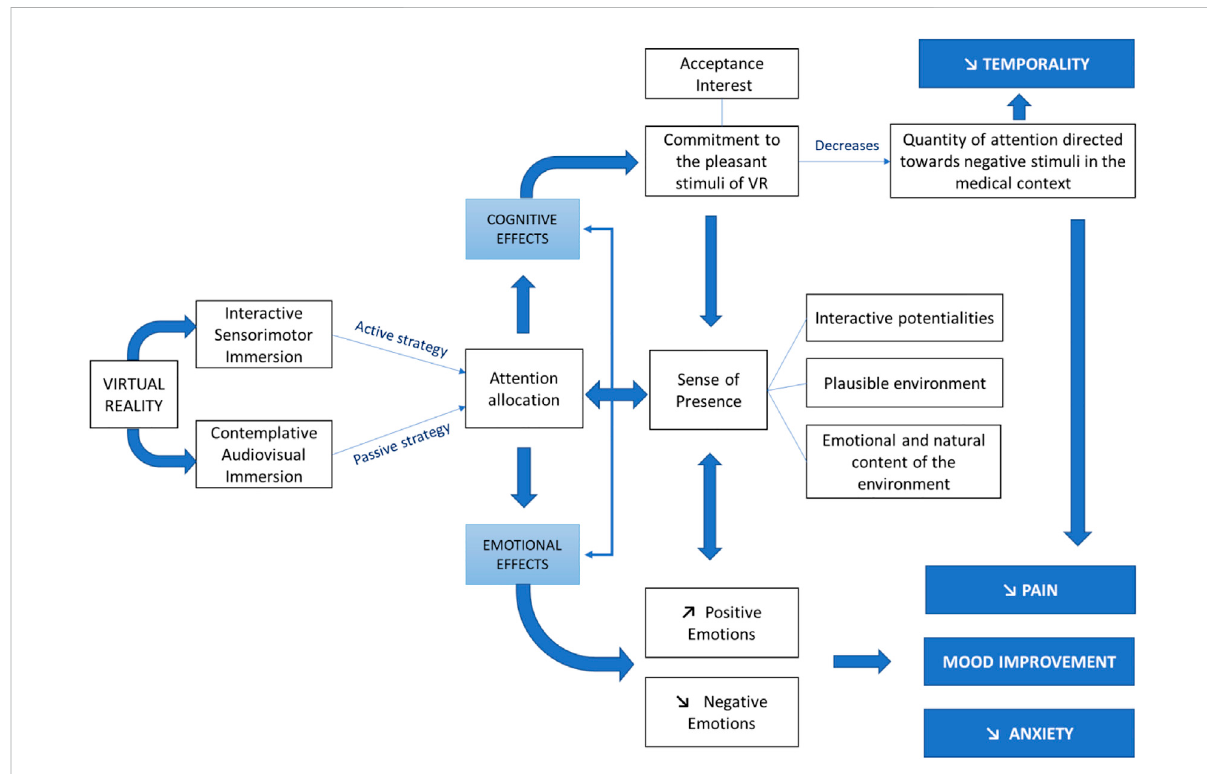
FIGURE 4 Model of the mechanisms involved in VR distractive experience and underlying its bene fi